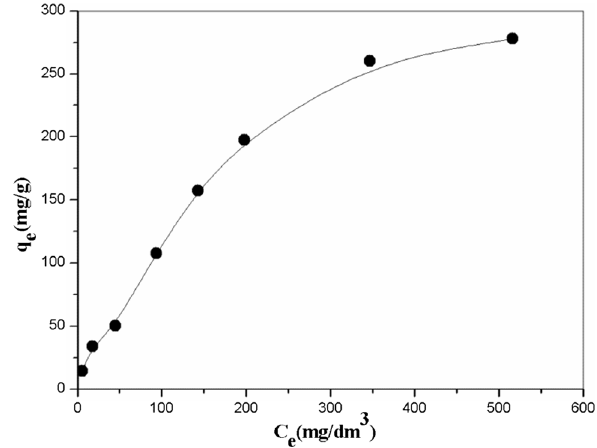
Fig. 8 Equilibrium adsorption data for Rh6G on composite at pH = 6 ( m = 200 mg, V = 200 cm 3 , T = 20 °C, equilibrium time = 24